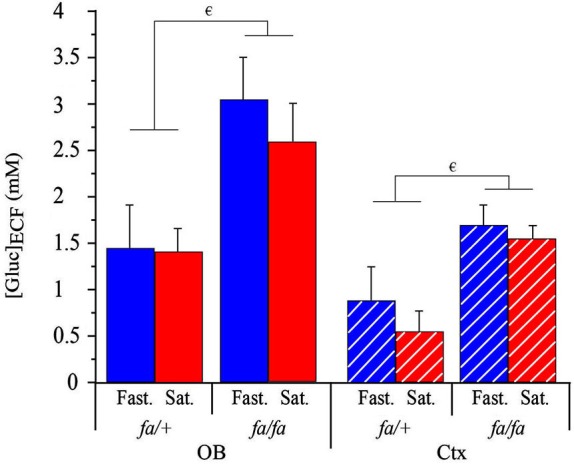
Genotype effect on the [Gluc]ECF at steady state in OB and cortex. [Gluc]ECF in OB (full bars) and in cortex (Ctx, hatched bars) of lean fa/+ (left) and obese fa/fa (right) in fasted (Fast., blue) and satiated (Sat., red) sates. A three-way ANOVA with brain areas (OB and cortex), feeding state and genotype as factors showed a significant effect of brain areas (not shown) and genotype (not shown). Both in OB and Ctx, [Gluc]ECF were higher in fa/fa compared to fa/+ (Mann Whitney tests, €
P < 0.05 for each area brain). For each genotype, [Gluc]ECF was significantly higher in OB compared to Ctx (not shown). Values are expressed as the mean ± SEM, n = 4/feeding state/genotype.